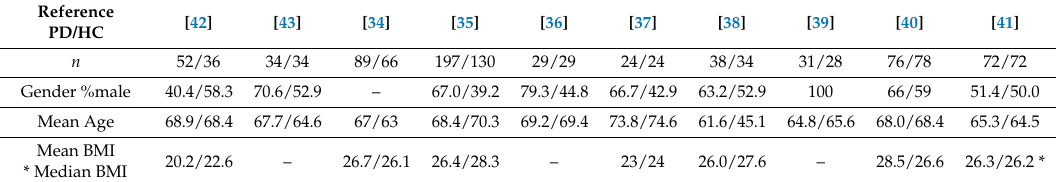
Table 1. Demographics and clinical data of Parkinson’s disease (PD) cases and human controls (HC).